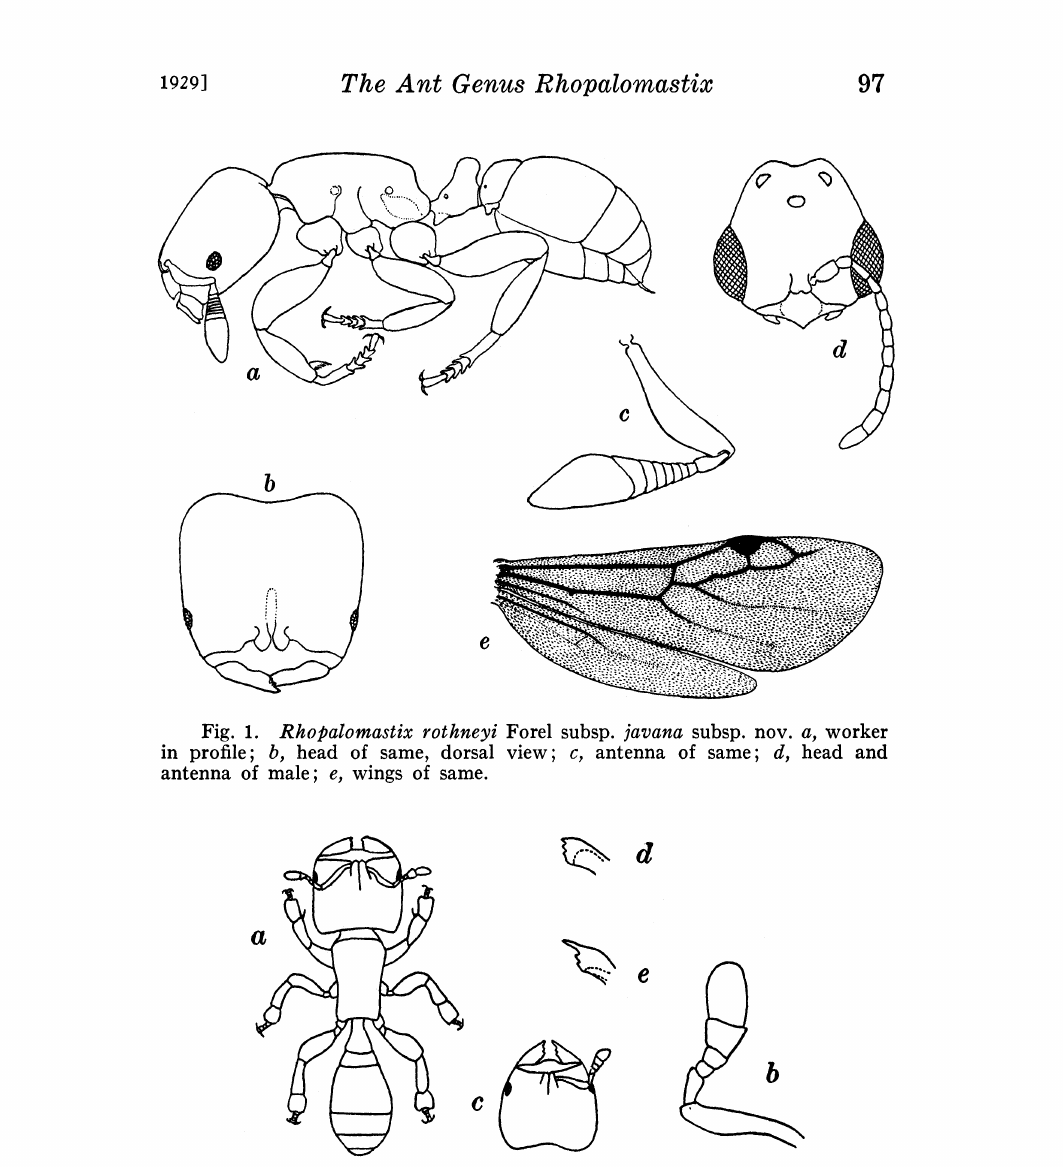
Fig. 2. Melissotarsus beccarii Emery. a, broad-headed worker, dorsal view; b, antenna of same; c, head of narrow-headed worker (After C. Emery); d, mandible of broad-headed worker; e, mandible of narrow-headed worker (After G.